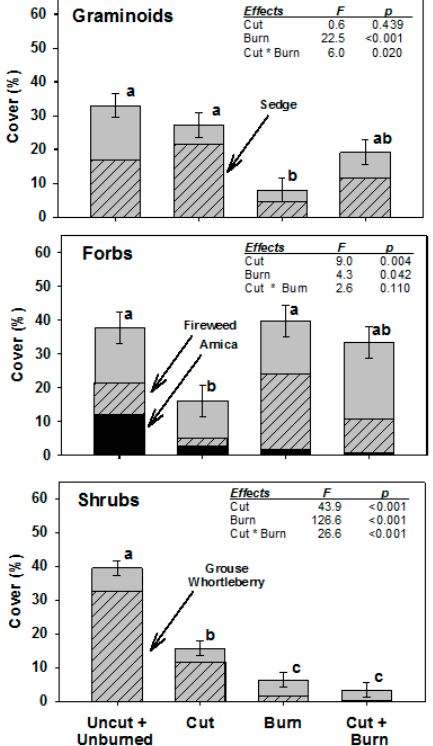
Figure 4. Understory plant cover in bark beetle-infested, cut and burned forest combinations at the Church’s Park Fire, Colorado during August 2014. Data are means of total plant cover (gray bar) by plant growth form with standard error bars for twelve stand-scale sampling areas per ecosystem condition. The sum of plant growth forms may exceed 100% within treatment due to overlapping plant canopy layers. Different letters indicate that treatment values differ based on Tukey’s pairwise adjusted comparisons. Cover of the most abundant (hatched) or second-most abundant (blackened) species in each growth form are displayed and identified by arrows.